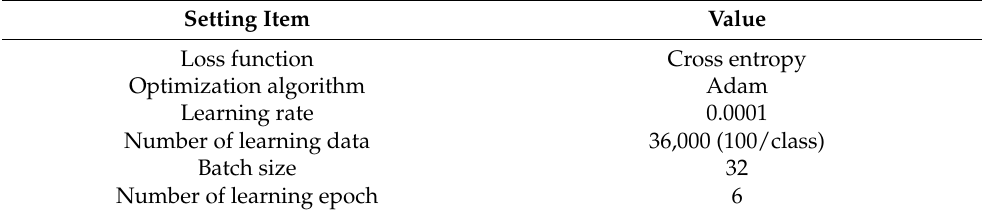
Table 1. The details of the learning